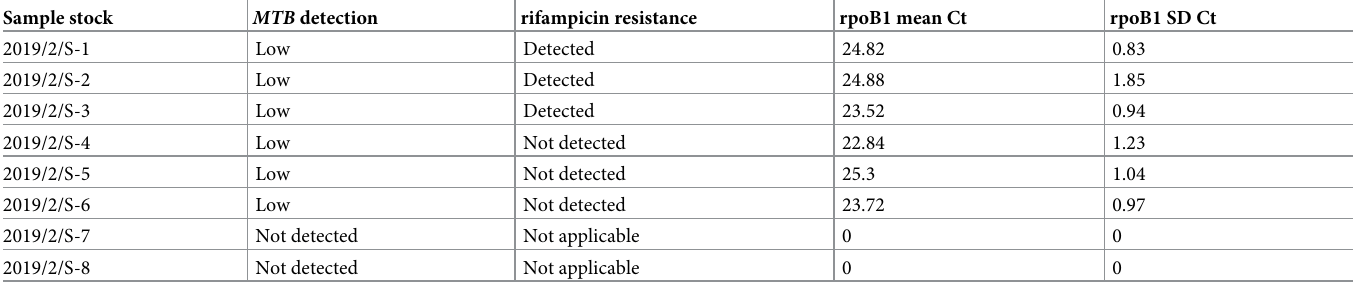
Table 1. Pretest results obtained with a 1:10 serial dilution. Sample